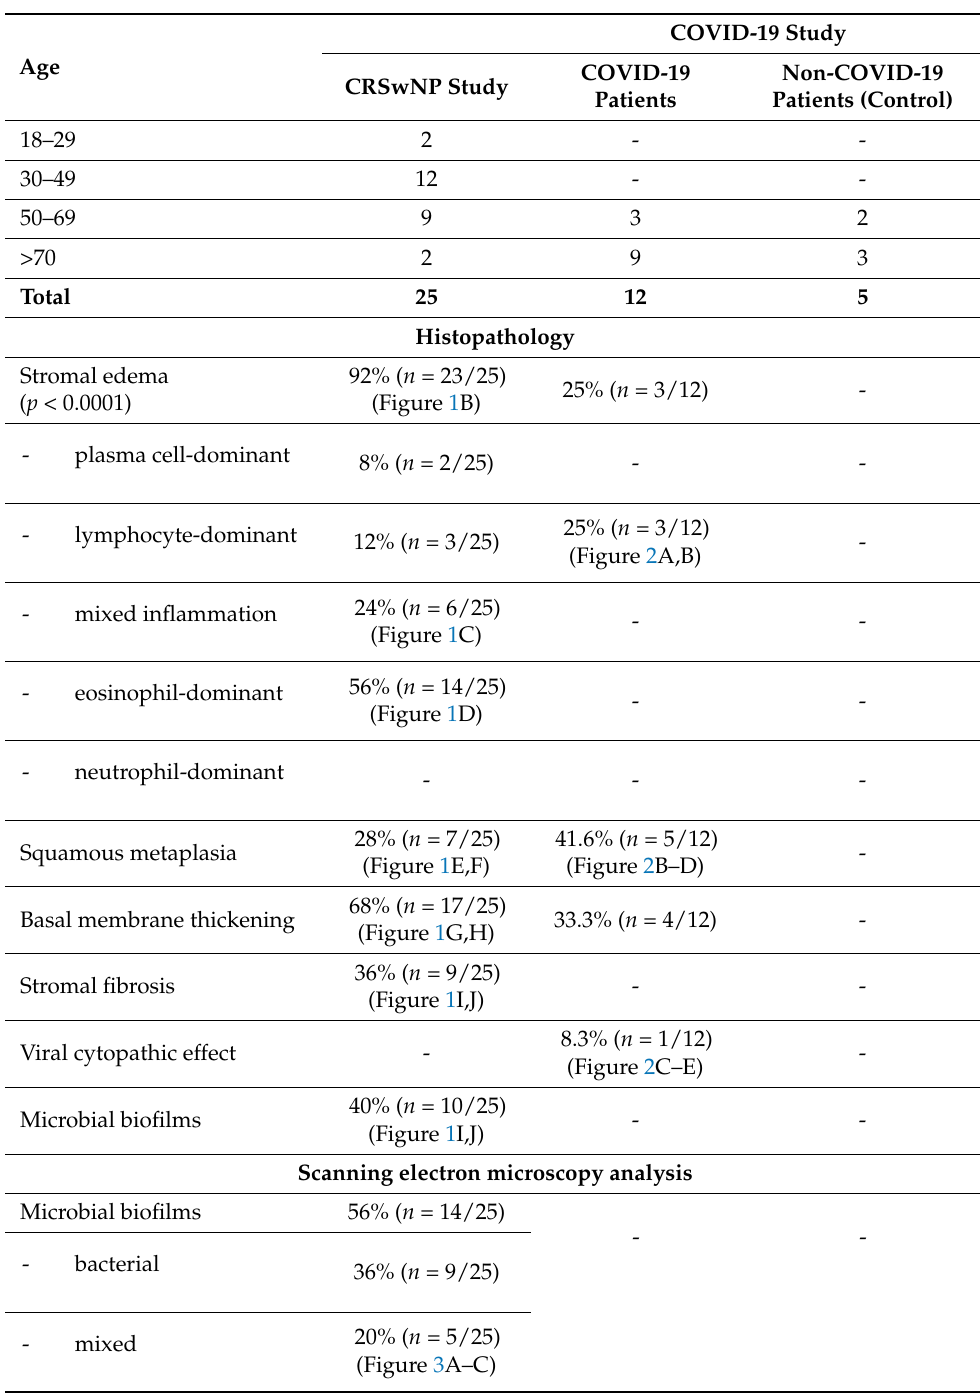
Table 2. Age distribution, microscopic findings, and tissue IL-33 concentration of the nasal mucosa in CRSwNP versus